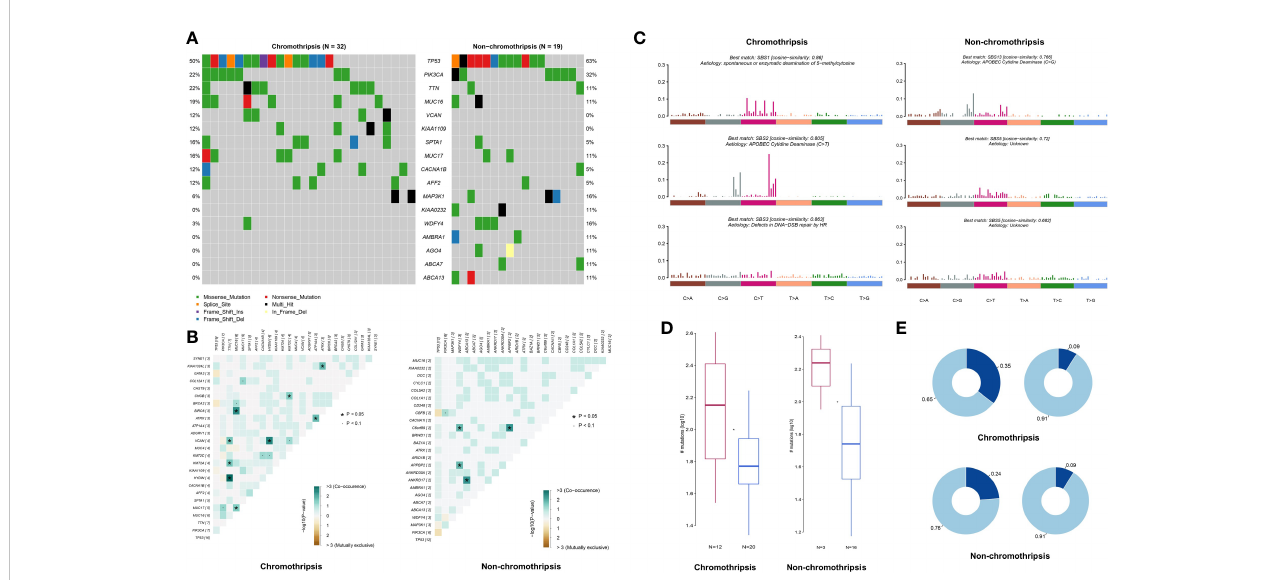
FIGURE 7 Genomic mutation characteristics of breast cancer in TCGA database. (A) Difference in mutation frequency between chromothripsis and non- chromothripsis groups in breast cancer. (B) Common mutation pro fi les of chromothripsis and non-chromothripsis groups in breast cancer. (C) Mutation signature of chromothripsis and non-chromothripsis groups in breast cancer. (D) Samples enriched or not for APOBEC in the chromothripsis and non- chromothripsis groups. (E) TCW motif burden in samples enriched or not for APOBEC in the chromothripsis and non-chromothripsis